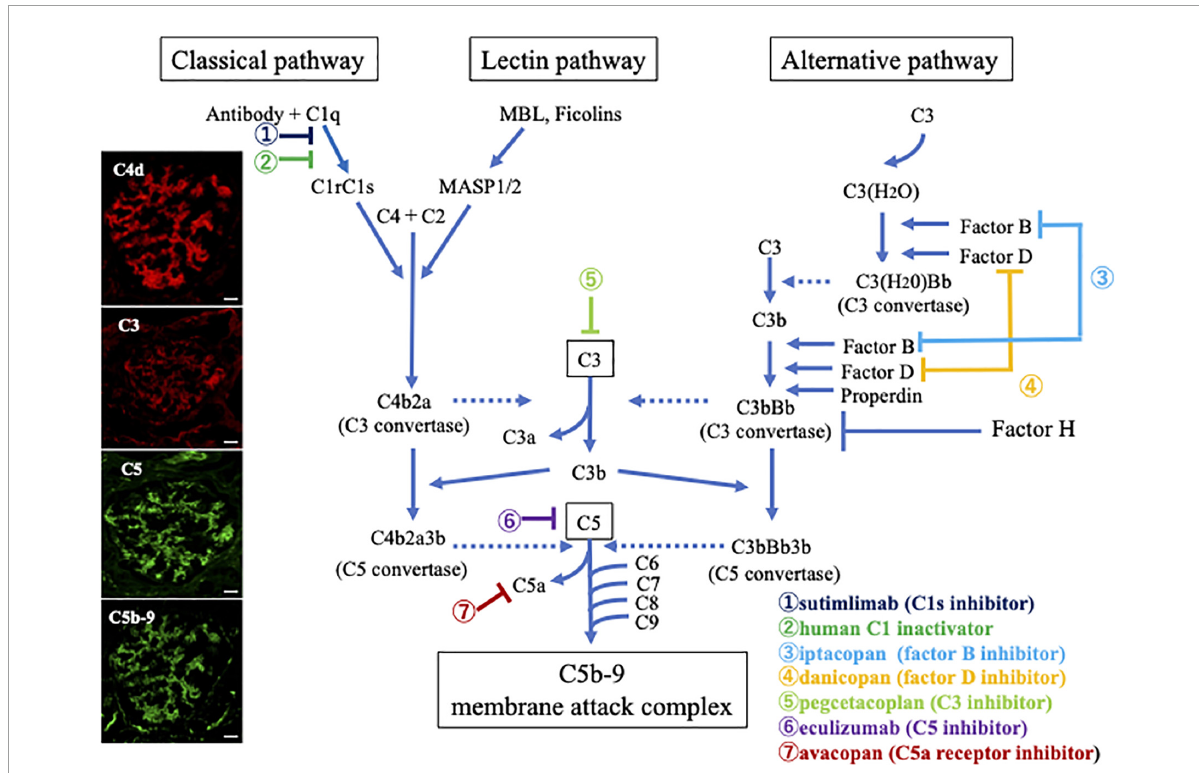
FIGURE1 Overview illustration of the complement activation system with therapeutic targets, and representative photomicrographs of the deposition of complement breakdown products in glomeruli of a patient with myeloperoxidase (MPO)-anti-neutrophil cytoplasmic antibody (ANCA)-associated glomerulonephritis (AAGN). Photographs on the left side show immunofluorescence staining for C4d (Alexa Fluor 594: red), C3 (Alexa Fluor 594: red), C5 (Alexa Fluor 488: green), and C5b-9 (Alexa Fluor 488: green) in a renal biopsy specimen of a patient with MPO-AAGN (Original magnification: × 400, Scale bars = 20.0 µ m in all photographs). The positive staining results suggest that immune complexes activate the classical complement pathway, leading to the activation of the final common pathway and formation of C5b-9 in patients with MPO-AAGN. Outlines of other pathways, including the lectin and alternative pathways and possible therapeutic targets are also